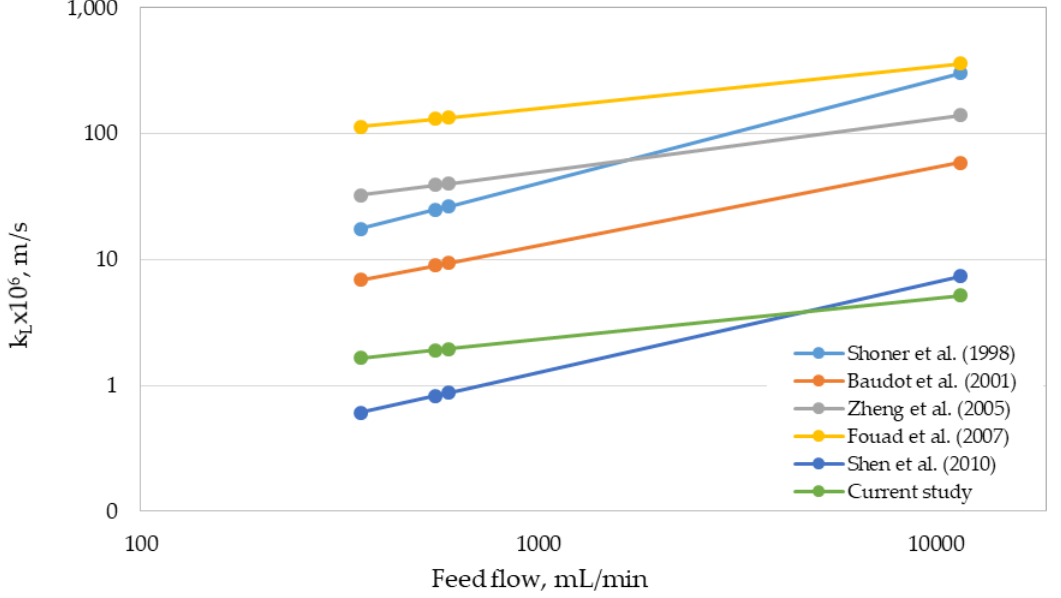
Figure 6. Comparison of local mass-transfer coefficients for the 2.5 × 8 Extra Flow module estimated from different correlations with respect to the feed flow.